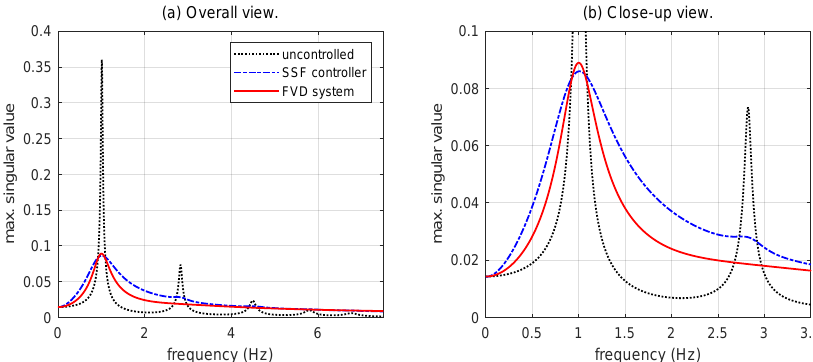
Figure 4. Maximum singular values of the FRFs corresponding to the uncontrolled building (black dotted line), the optimal SSF controller (blue dash-dotted line) and the computed FVD system (red solid line). ( a ) Overall view. ( b ) Close-up view of the main resonant